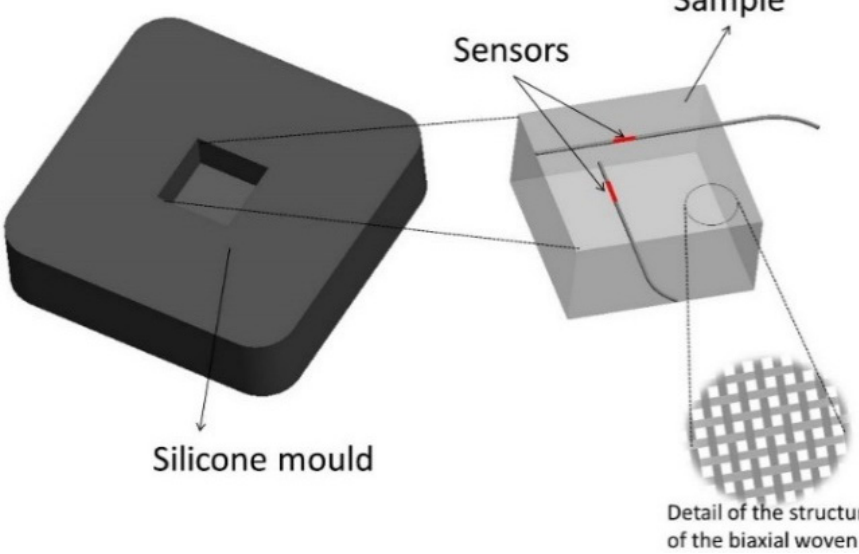
Figure 11. Schematic representation of the structure of the biaxial woven prepreg and the locations of the sensors, in two orthogonal directions, in the sample (adapted from